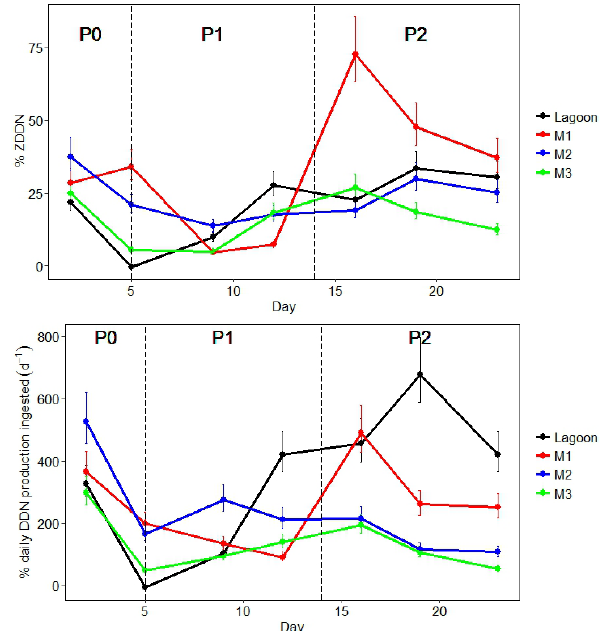
Figure 6. Average percent contribution of diazotroph-derived nitro- gen (DDN) to zooplankton biomass (above) and estimated average percent of fixed nitrogen ingested by zooplanktonday − 1 over the course of the 23-day VAHINE experiment (13 January–4 Febru- ary 2013) for the three mesocosms (M1–3) and the lagoon waters. P0, P1, and P2 refer to the pre-phosphorous fertilization, DDA- dominated, and UCYN-C-dominated periods of the experiment, re- spectively. Error bars in the upper panel represent the minimum and maximum values of % ZDDN calculated using a trophic enrich- ment factor range of 2.2 ± 0.3‰ (McCutchan et al., 2003; Vanderk- lift and Ponsard, 2003) and diazotroph δ 15 N value range of − 1 to − 2‰ (Montoya et al., 2002). The error bars in the lower panel re- flect the range of percent DDN production ingested by zooplankton using the range of percent